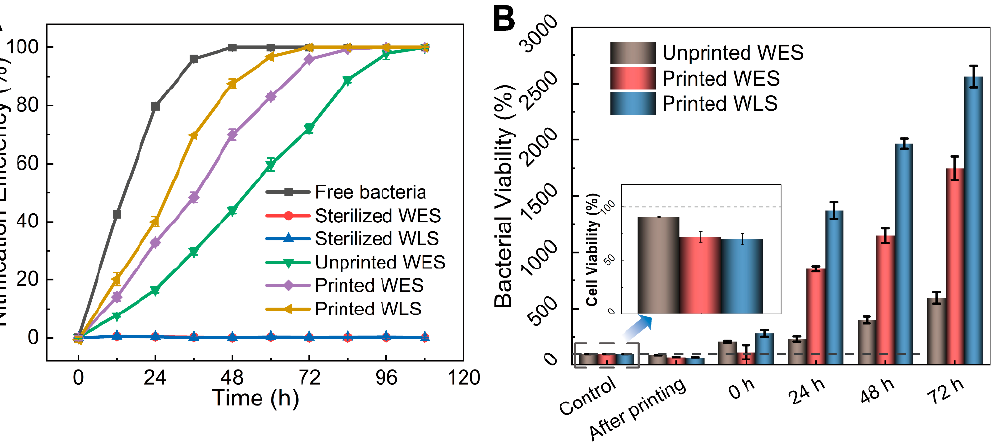
Figure 10. ( A ) Nitrogen removal effects of different materials. ( B ) Bacterial viability of printed WES, unprinted WES and printed WLS sample groups.